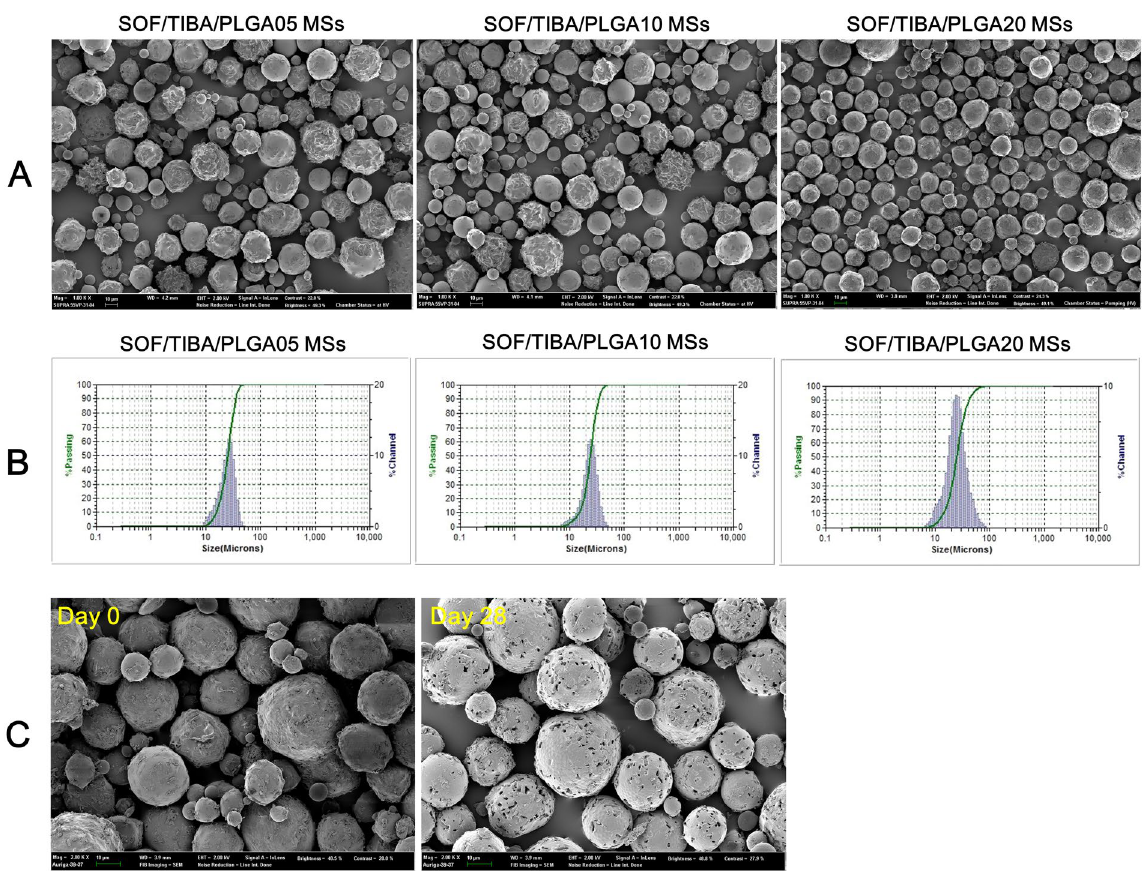
Figure 2. Physicochemical characterizations of developed SOF/TIBA/PLGA MSs. ( A ) FE-SEM images of SOF/ TIBA/PLGA MSs are shown. The length of scale bar is 10 µ m. ( B ) Size distribution charts of SOF/TIBA/PLGA MSs are presented. ( C ) FE-SEM images of SOF/TIBA/PLGA20 MSs at day 0 and day 28 after incubation in serum (50% FBS) are exhibited. The length of scale bar is 10 µ m.